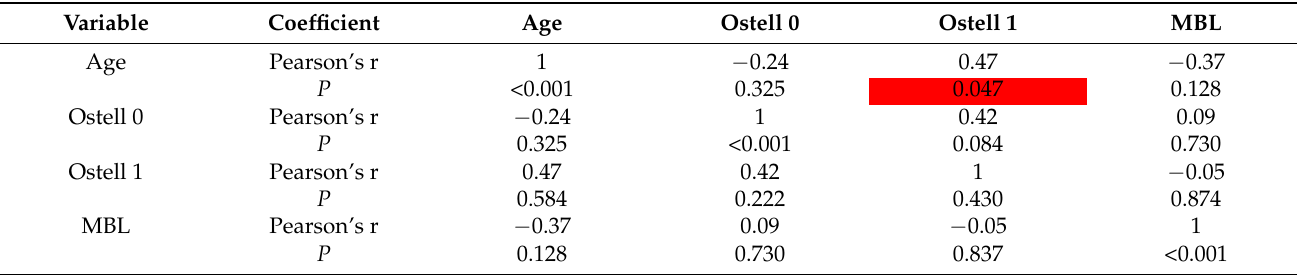
Table 3. Linear correlation coefficients for group one and their significance for the selected continuous variables. The statistically important differences are highlighted in red.